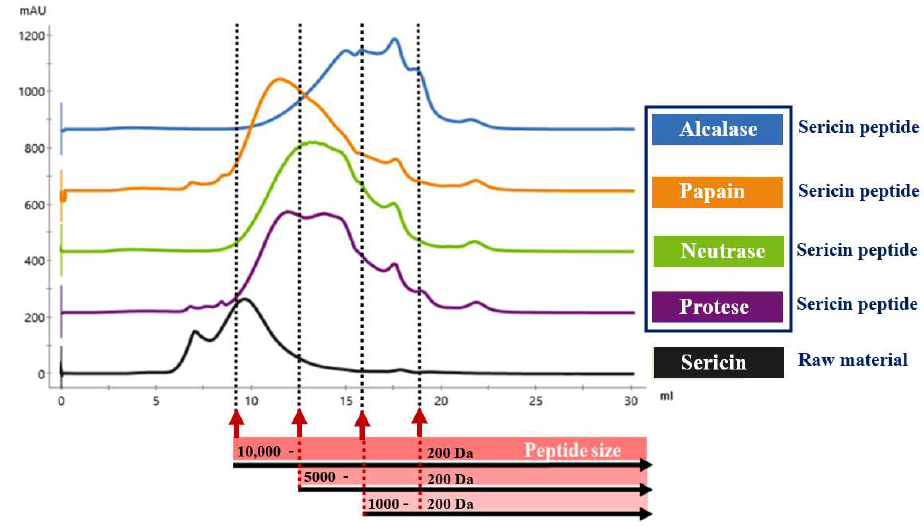
Figure 3. The chromatogram of sericin and sericin peptides on size exclusion chromatography.